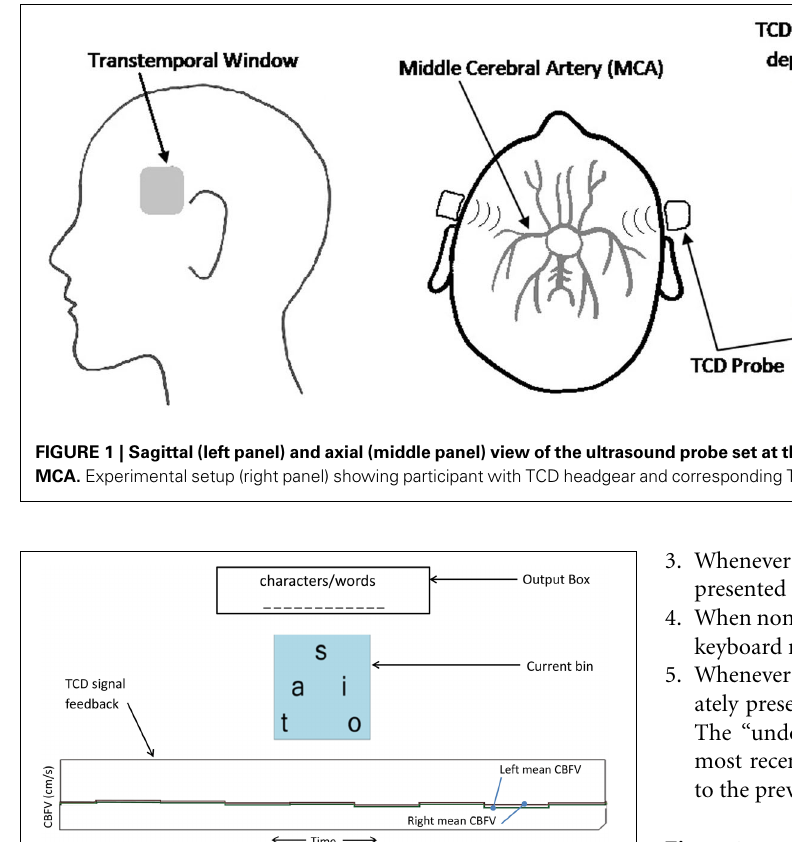
Figure 3 portrays an example of dynamic keyboard